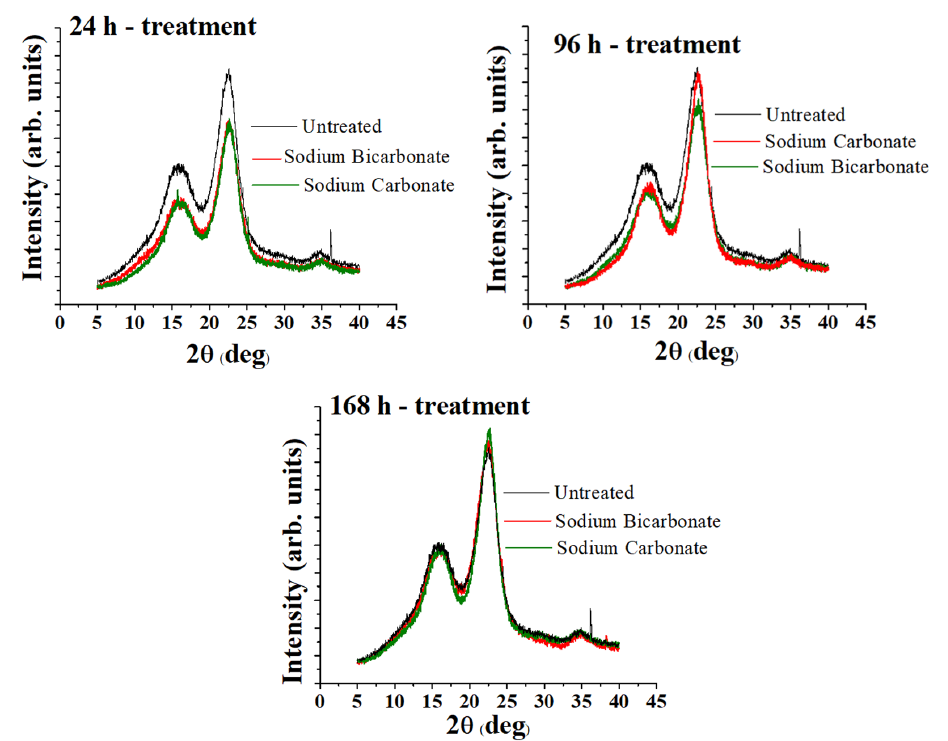
Figure 11. Comparative X-ray diffraction pattern of untreated and treated sisal fibres for 24 h (a), 96 h (b), and 168 h (c). Table 5. X-ray diffraction analysis: crystallinity index (I C